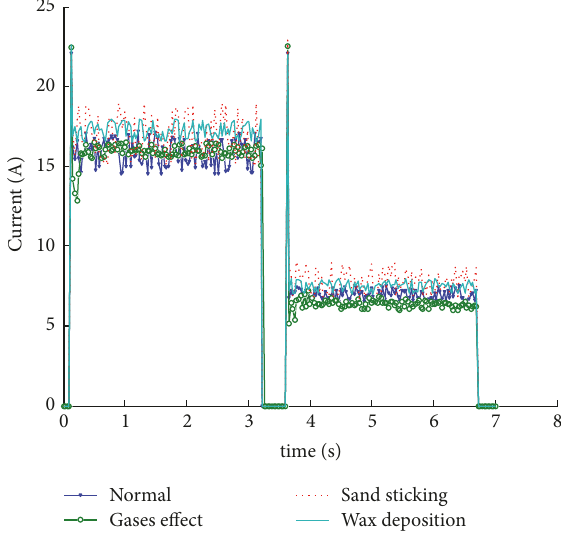
Figure 2: Current curves of linear